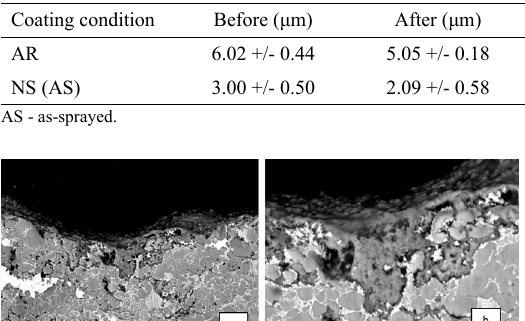
O ) can be clearly seen on the surface of 2 3